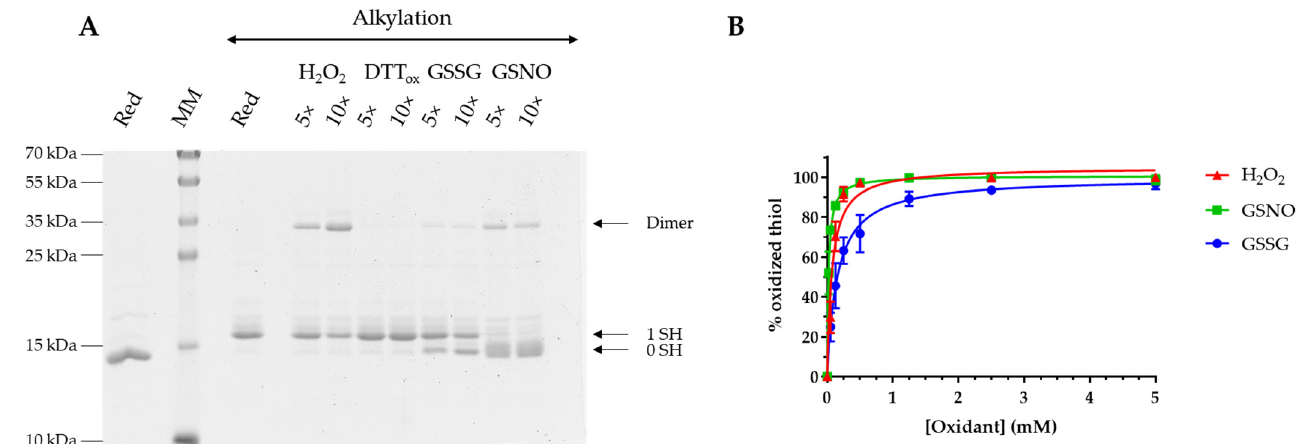
Figure 2. Sensibility of At GRXS15 towards oxidants. Pre-reduced recombinant At GRXS15 (13 µ M) was incubated with a 5- to 10-fold molar excess of H 2 O 2 , DTT ox , GSSG, and GSNO for 2 h at RT. Remaining reduced thiols were then alkylated before protein migration on non-reducing SDS-PAGE. The numbers on the right correspond to the number of thiols that remained reduced upon treatment and thus were alkylated. A gel representative of at least three independent experiments is shown here ( A ). In another series of experiments, pre-reduced recombinant At GRXS15 (5 µM) was incubated for 1 h at RT with H 2 O 2 , GSSG, and GSNO at concentrations ranging from 50 µM to 10 mM. The remaining free thiols were alkylated with mBBr and quantified through measurement of the resulting fluorescence. The decrease of fluorescence, represented as a percentage of oxidized thiol, was plotted against the oxidant concentration for determination of S 0 . 5 value ( B ). Data are represented as mean ± SD of three independent experiments.